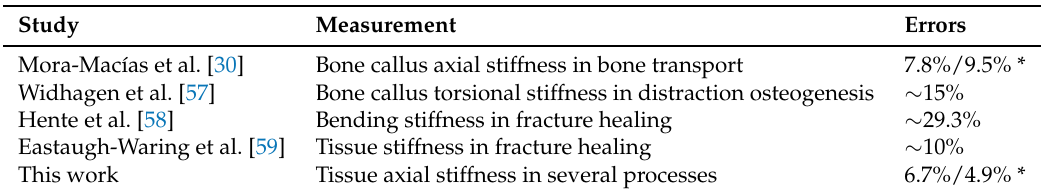
Table 3. Medical devices for bone regeneration applications that reported error data in their